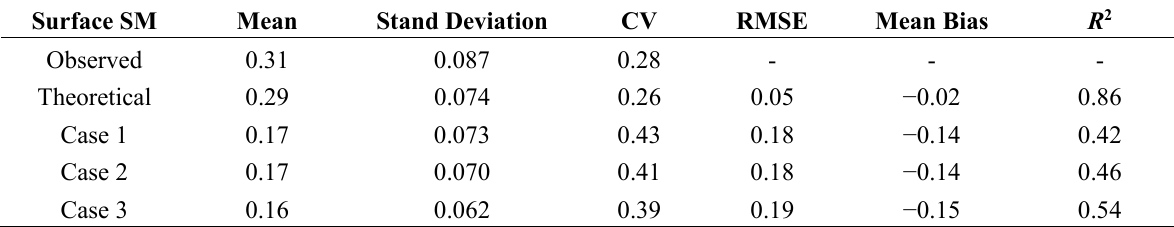
Figure 9. Cumulative distribution curves of observed surface soil moisture and those estimated from the trapezoidal method with different boundaries edges. Cases 1, 2 and 3 correspond to different warm edges shown in Figure 7. Table 1. Statistical analysis of surface soil moisture from observations and estimated from the trapezoidal method with different boundaries edges on 2 September 2010. Cases 1, 2 and 3 correspond to different warm edges shown in Figure